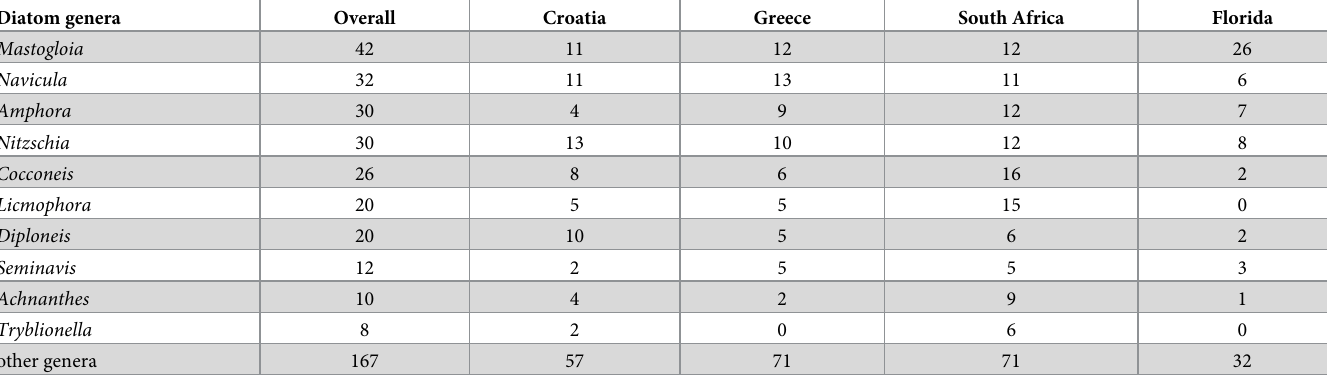
Table 2. The number of diatom taxa in the most diverse genera in samples from different localities. Diatom genera Overall Croatia Greece South Africa Florida Mastogloia 42 11 12 26 Navicula 32 11 13 Amphora 30 Cocconeis 26 Licmophora